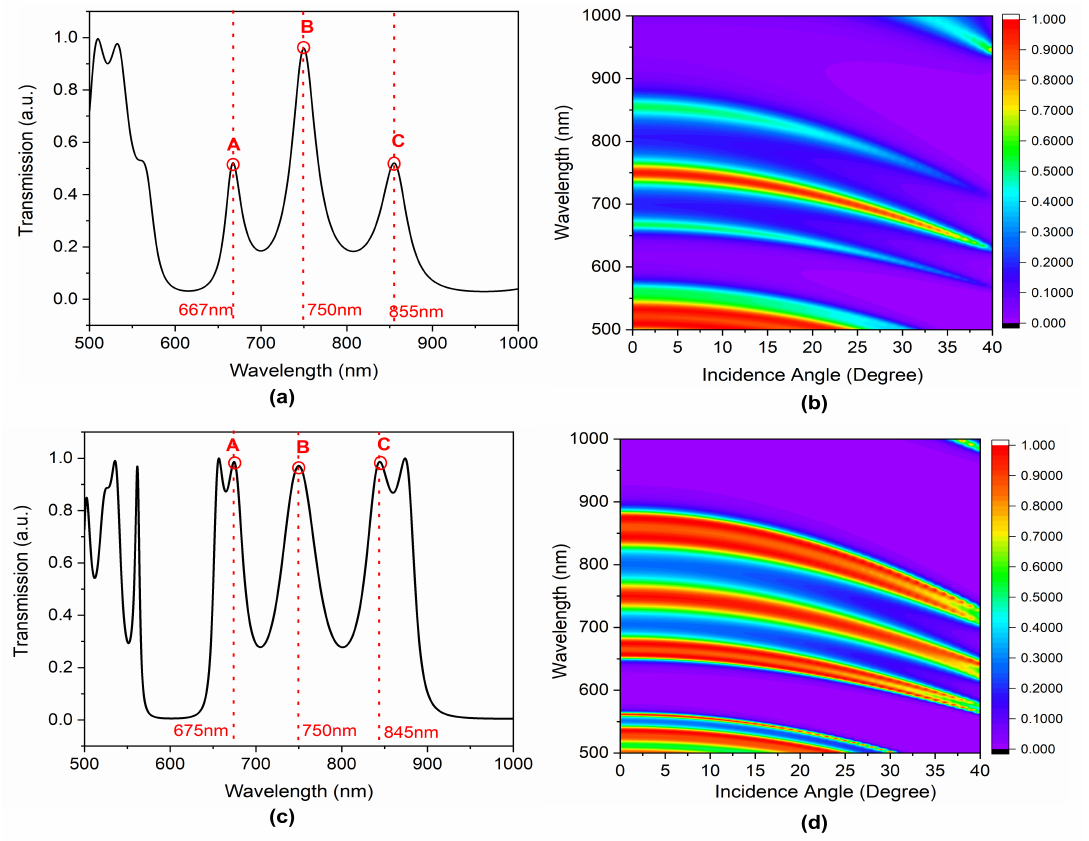
Figure 2. Transmission spectrum of proposed QPhC structure at normal incidence ( a ) for n = 6 QPhC structure; ( b ) corresponding angular dispersion characteristics. ( c ) n = 7 QPhC structure and ( d ) corresponding angular dispersion